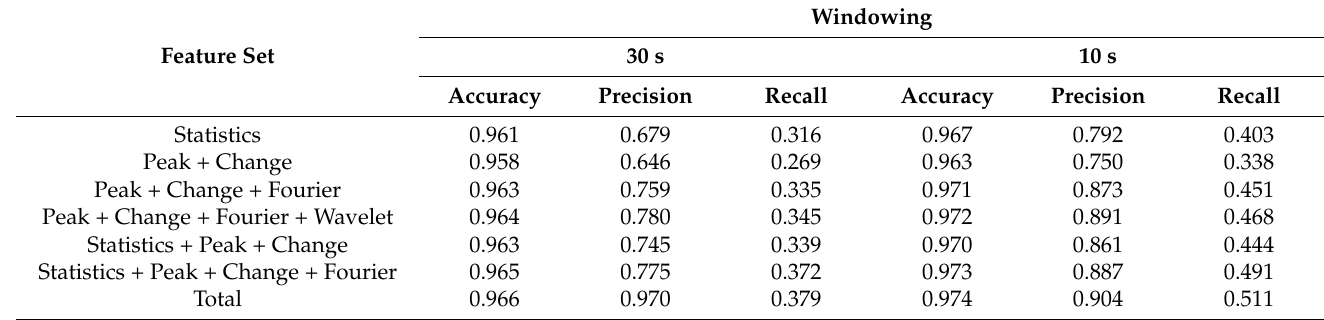
Table 3. Prediction results according to different windowing intervals and different feature sets.